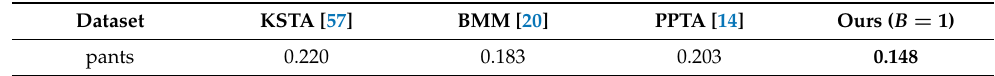
Table 7. e 3 D on the pants